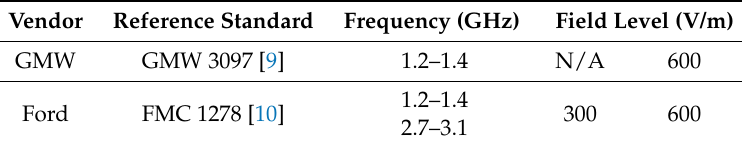
Table 1. Radiated immunity test levels defined by the automotive vendors.